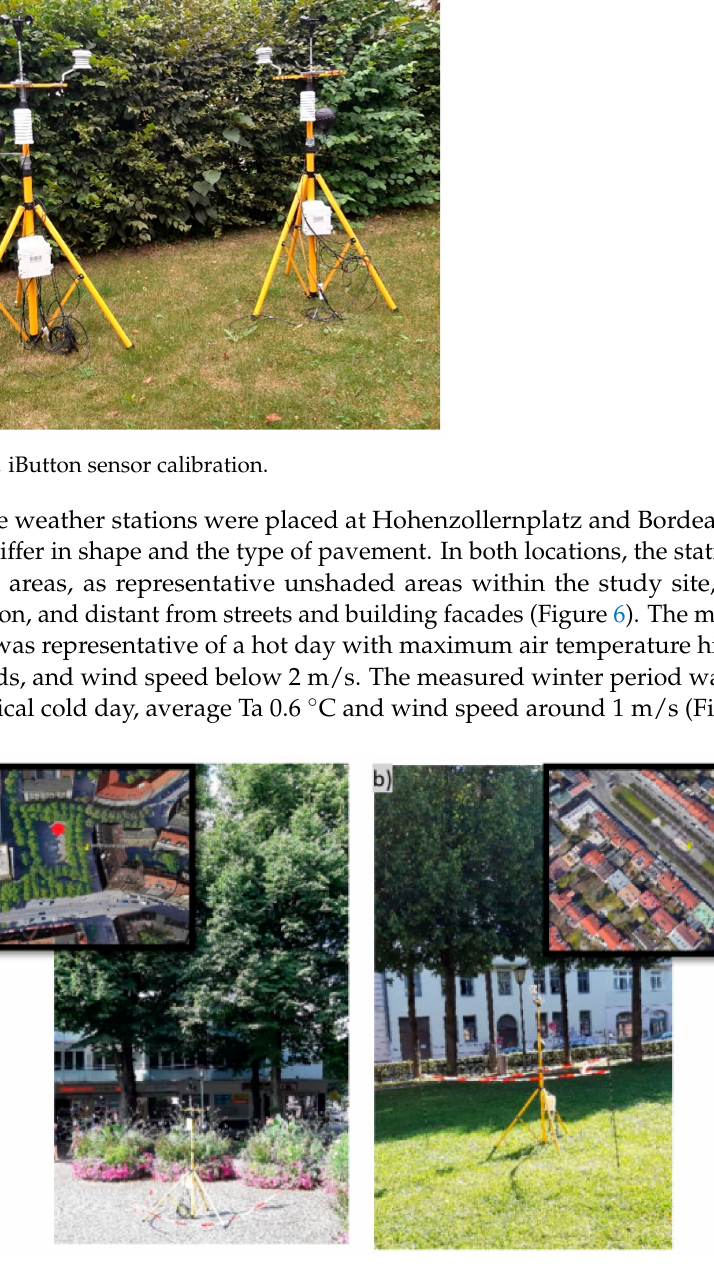
Figure 6. Summer field measurement. Hohenzollernplatz ( a ); Bordeauxplatz ( b ). Source: Priscila W. Stark da Silva (with basic geographical data provided by www.google.com accessed on 5 February